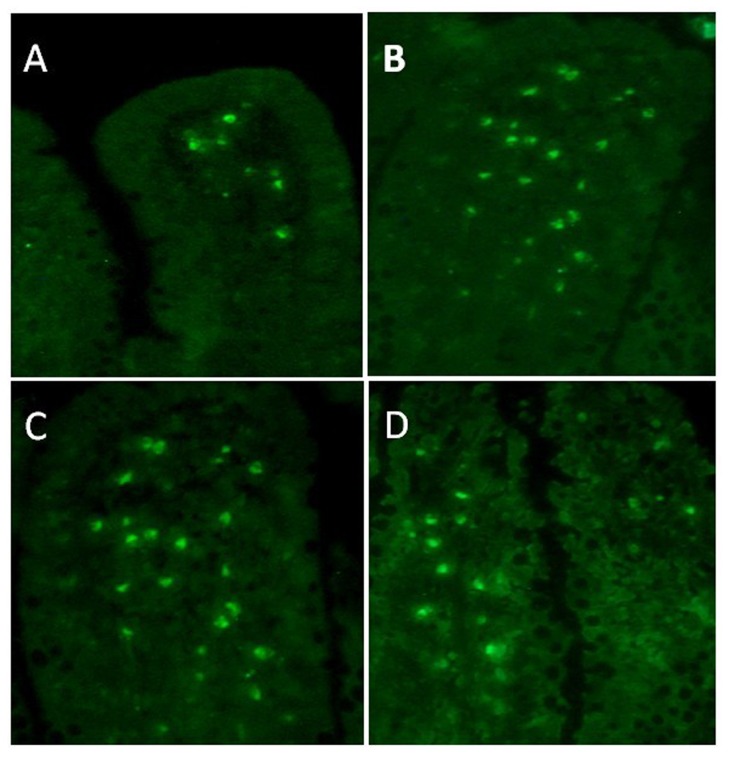
MSCs homing photograph (40×).After cell transplantation, engrafted cells were detected by Y chromosome in
situ hybridization at 1, 4, 7, and 10 days (the green fluorenscent point represents positive donor derived cells), which corresponded to graphs A, B, C, and D respectively. Most of the homed cells were located at mucosal lamina propria, and the amounts of engrafted cells were more at 4 and 7days than 1 and 10 days postoperatively.